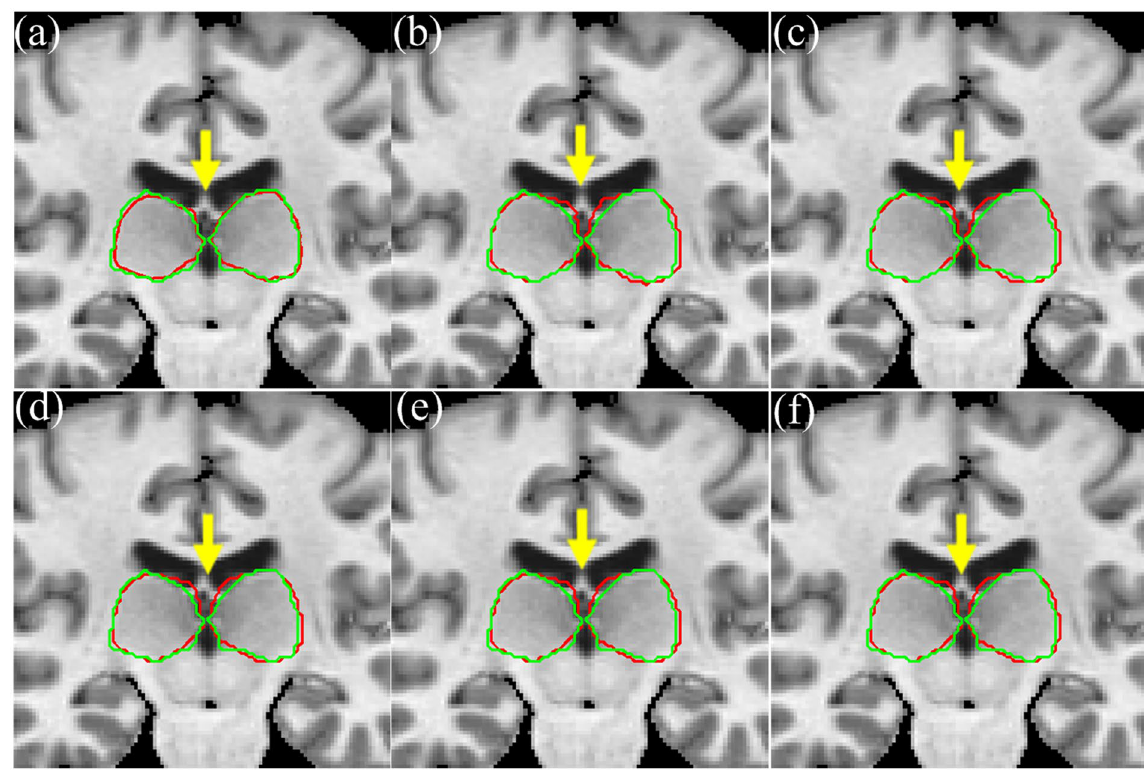
Figure 7. The segmentation results of MICCAI image No. 1006 by our method and five other methods. ( a ) Our method, ( b ) STAPLE, ( c ) Spatial STAPLE, ( d ) Major Voting, ( e ) Weight Voting, ( f ) SIMPLE. Automatic segmentation results are illustrated in red contour, the manually-delineated thalamus boundary shown by the green